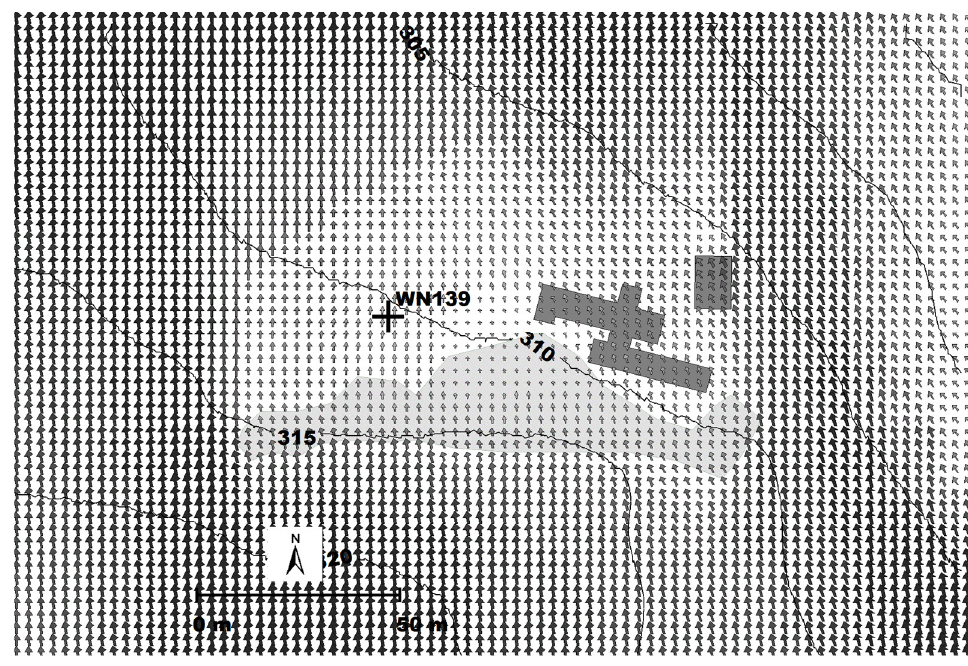
Figure 13. Example for a calculated microscale flow field 10 m above ground level for the 13 Octo- ber 2017, 2.p.m., utilizing GRAL-SCI. The vegetated area is marked with light grey and buildings by grey colors. Topography is indicated as black